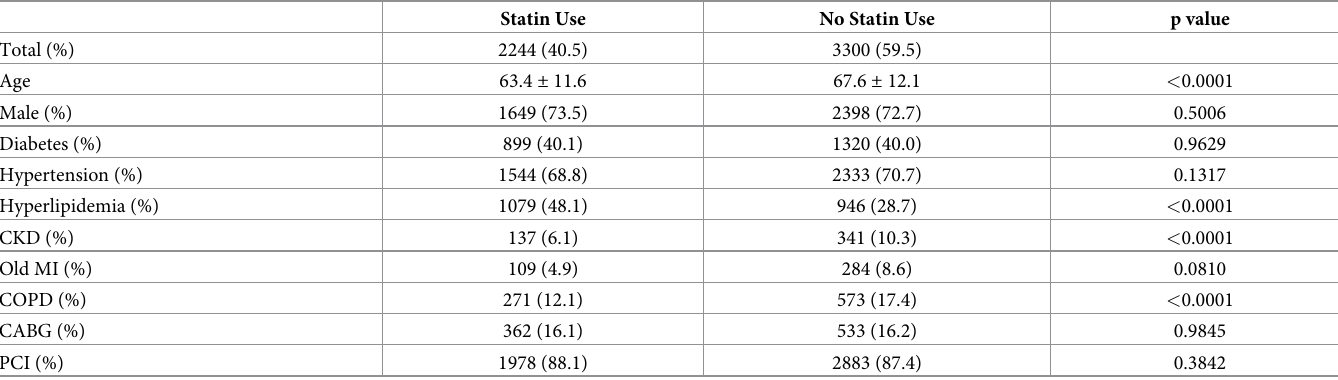
Table 4. Factors associated with statin use at 12 months.